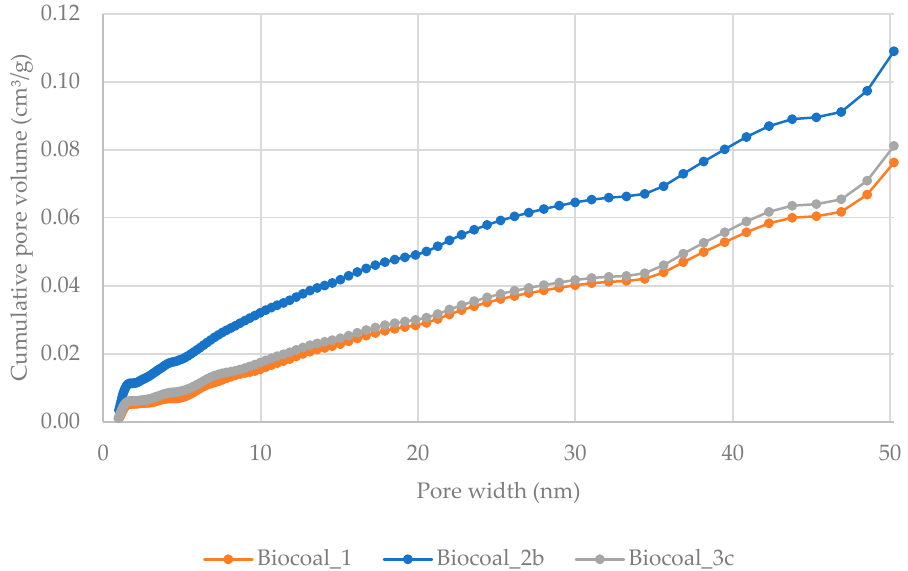
Figure 5. Pore size distribution of the biocoals (cases 1–3) determined by DFT